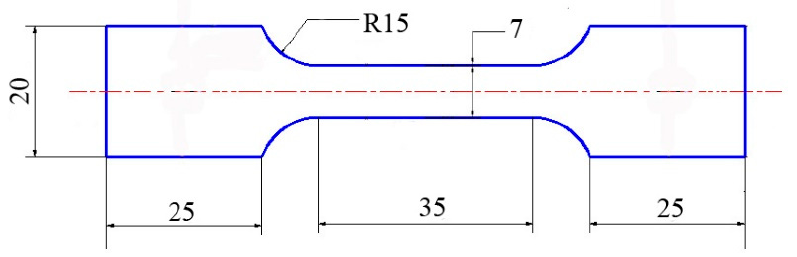
Figure 1. Dimensions (mm) of specimens for tensile tests.